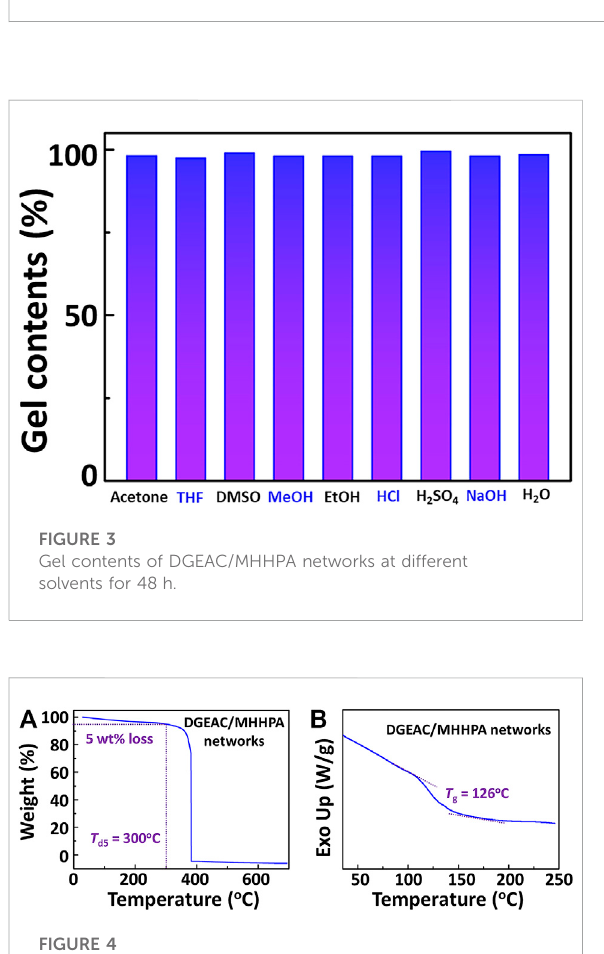
FIGURE 4 TGA (A) and DSC (B) curves of DGEAC/MHHPA networks.